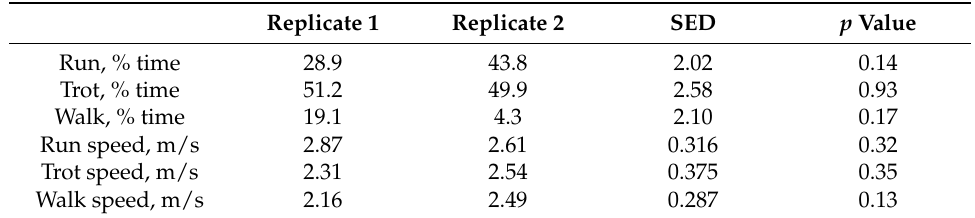
Table 3. Least square means for behaviours in replicates 1 and 2 for Naïve Marshalled (NM) calves.